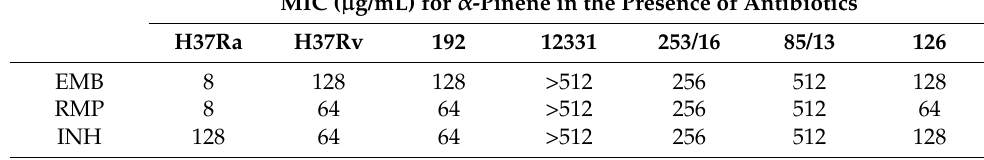
Table 4. The minimal inhibitory concentration values (MIC) obtained for terpenes tested in the presence of subinhibitory concentrations of